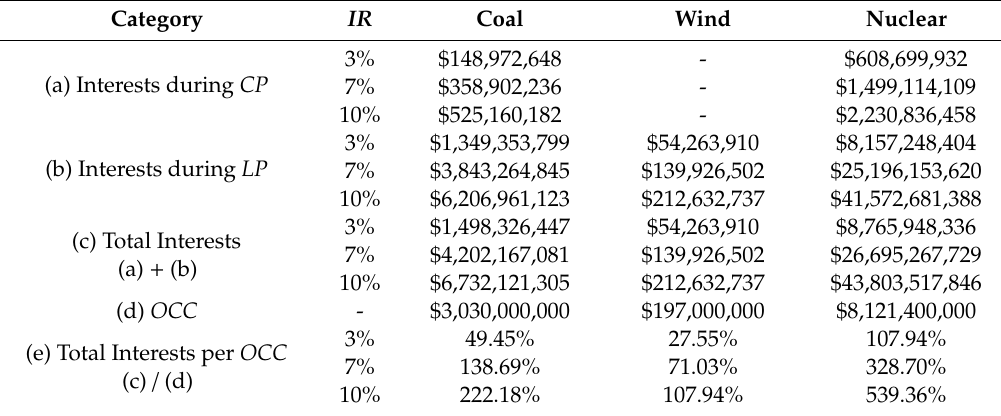
Table 5. Interests incurred during CP and LP for Coal, Wind, and